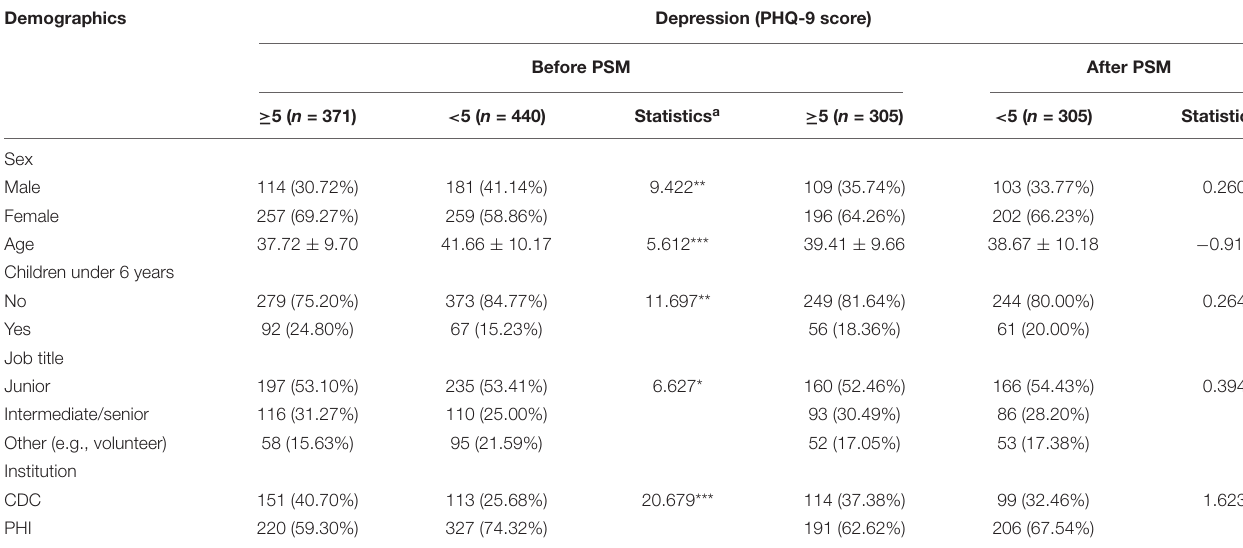
TABLE 2 | Demographic characteristics of the depression groups before and after PSM ( n ,